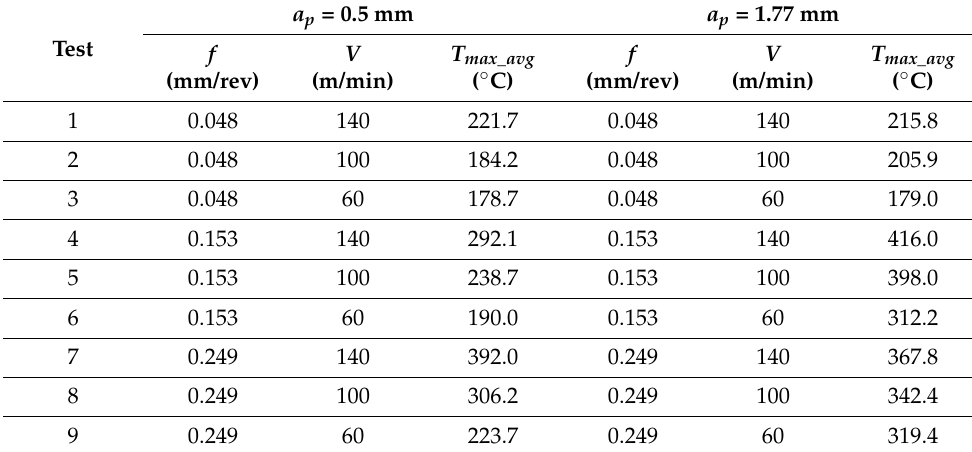
Figure 7. The thermovision image of the cutting zone ( a ) before the machining; ( b ) during the machining. Table 5. The mean-maximum temperature during the stabilized machining.